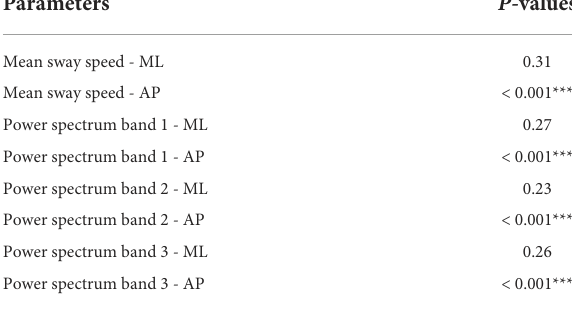
TABLE 3 Results of non-parametric ANOVA for postural sway